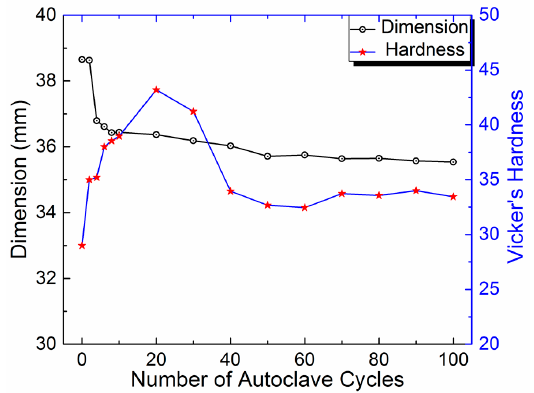
Figure 5. Change in the clip dimension with the hardness variation of the clip with respect to the number of autoclave cycles. Table 2. Comparison of the hardness values of test samples manufactured from 12 mm and 50 mm rods and from two different PEEK manufacturers.